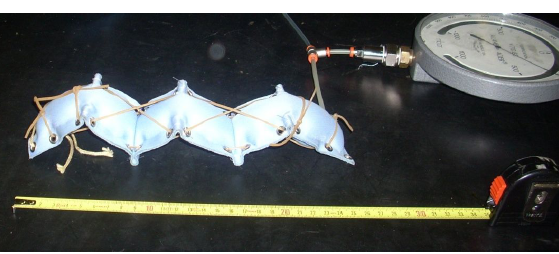
Figure 7. Worm actuator